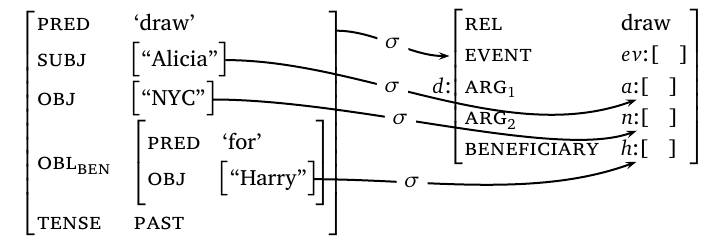
Figure 9: Structures and